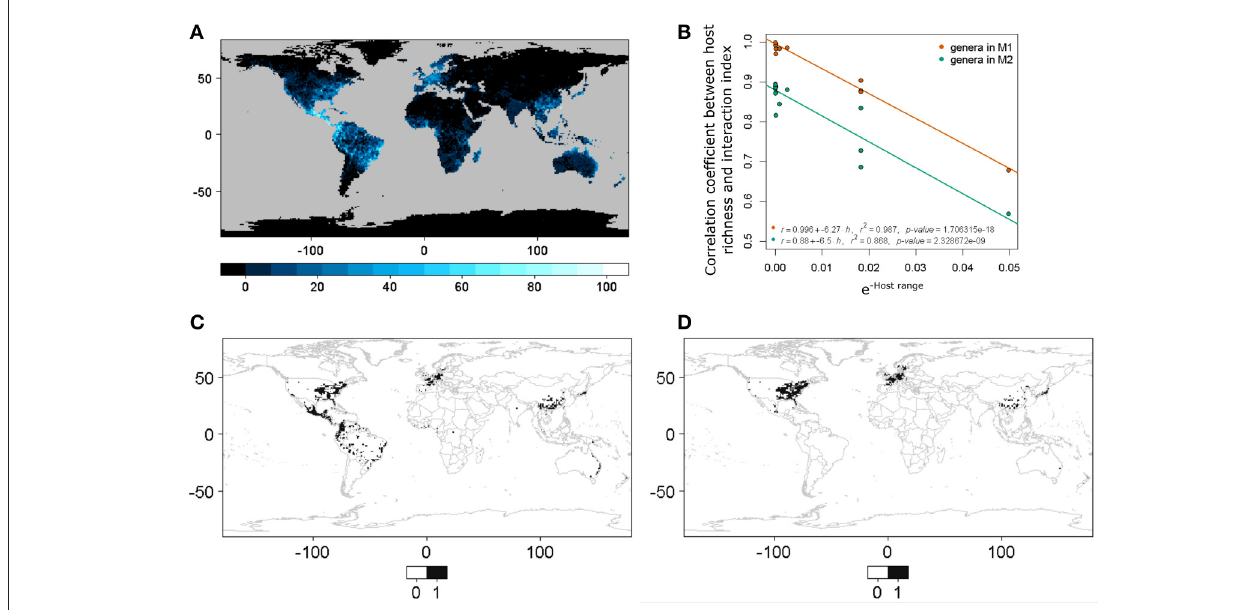
FIGURE 4 | (A) World host richness. This corresponds to host plant genera in M 1 . (B) Linear model between host range (negative exponential transformation, also see Equation 3; a small value implies a larger host range and vice versa) and the correlation coefficients between host richness and the interaction or infection spatial index. M 1 corresponds to host plant genera derived from the list of host plant species in the bark beetles database and M 2 to host plant genera in the phylogenetic tree after obtaining the occurrences for each genera directly using the R package spocc. (C) Binary predictive model for Xylosandrus crassiusculus , a generalist bark beetle species. (D) Binary predictive model for Xyleborus xylographus , a specialist bark beetle species. Note that cases (C,D) correspond to extremes in (B) , and that (C) has a higher correlation with species host richness than (D) .